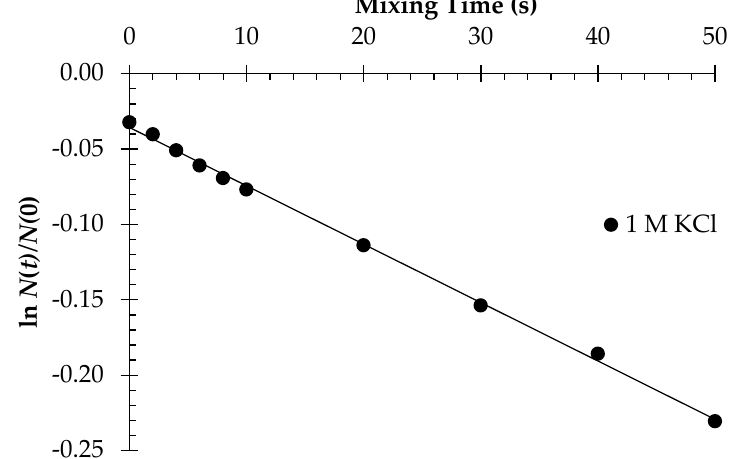
Figure 4. Variation of the total number of clusters per unit volume N ( t ) with the number of mixing time (s) for salt-induced coagulation ( N (0) = 5 × 10 7 cm −3 ).